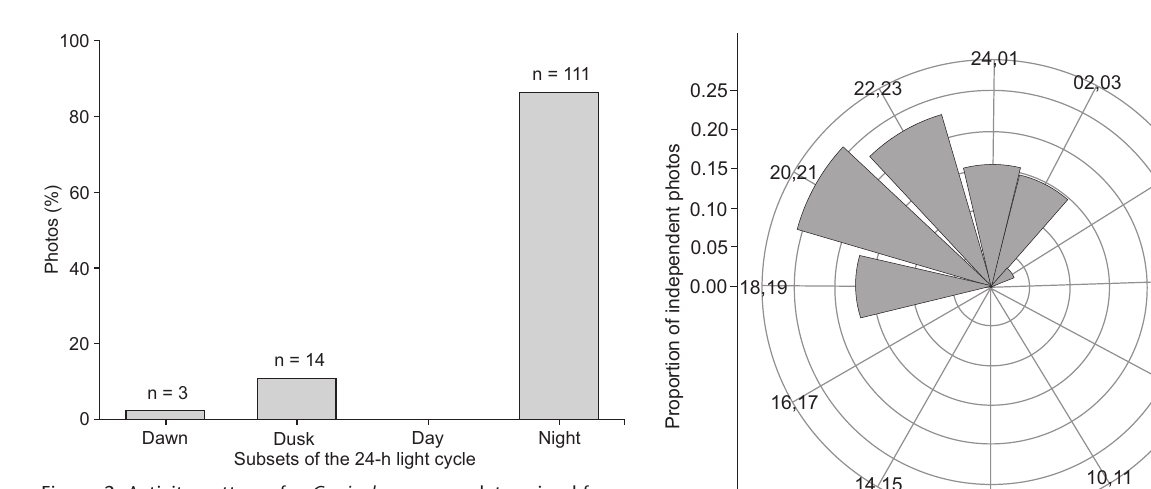
Figure 2. Activity patterns for Cuniculus paca as determined from camera trapping in southern Amazonia. The sample size of photos obtained is noted above each column. Data represent the per- centage of photos occurring within each of 4 designated subsets of the 24-hours diel cycle.